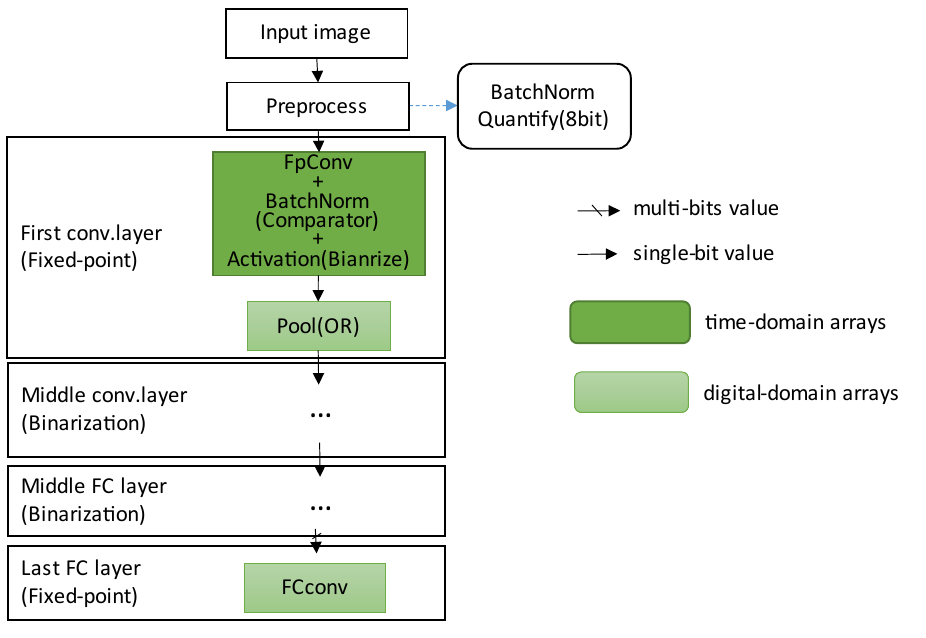
Figure 11. Mixed-precision model.